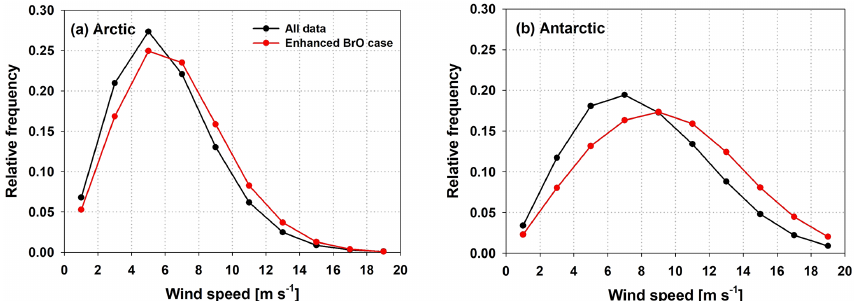
Figure 9. Frequency distribution of wind speed at 10m for all data (black line) and the enhanced BrO case (red line) in (a) the Arctic and (b) Antarctic sea ice regions in spring (Arctic: March to April; Antarctic: September to October).